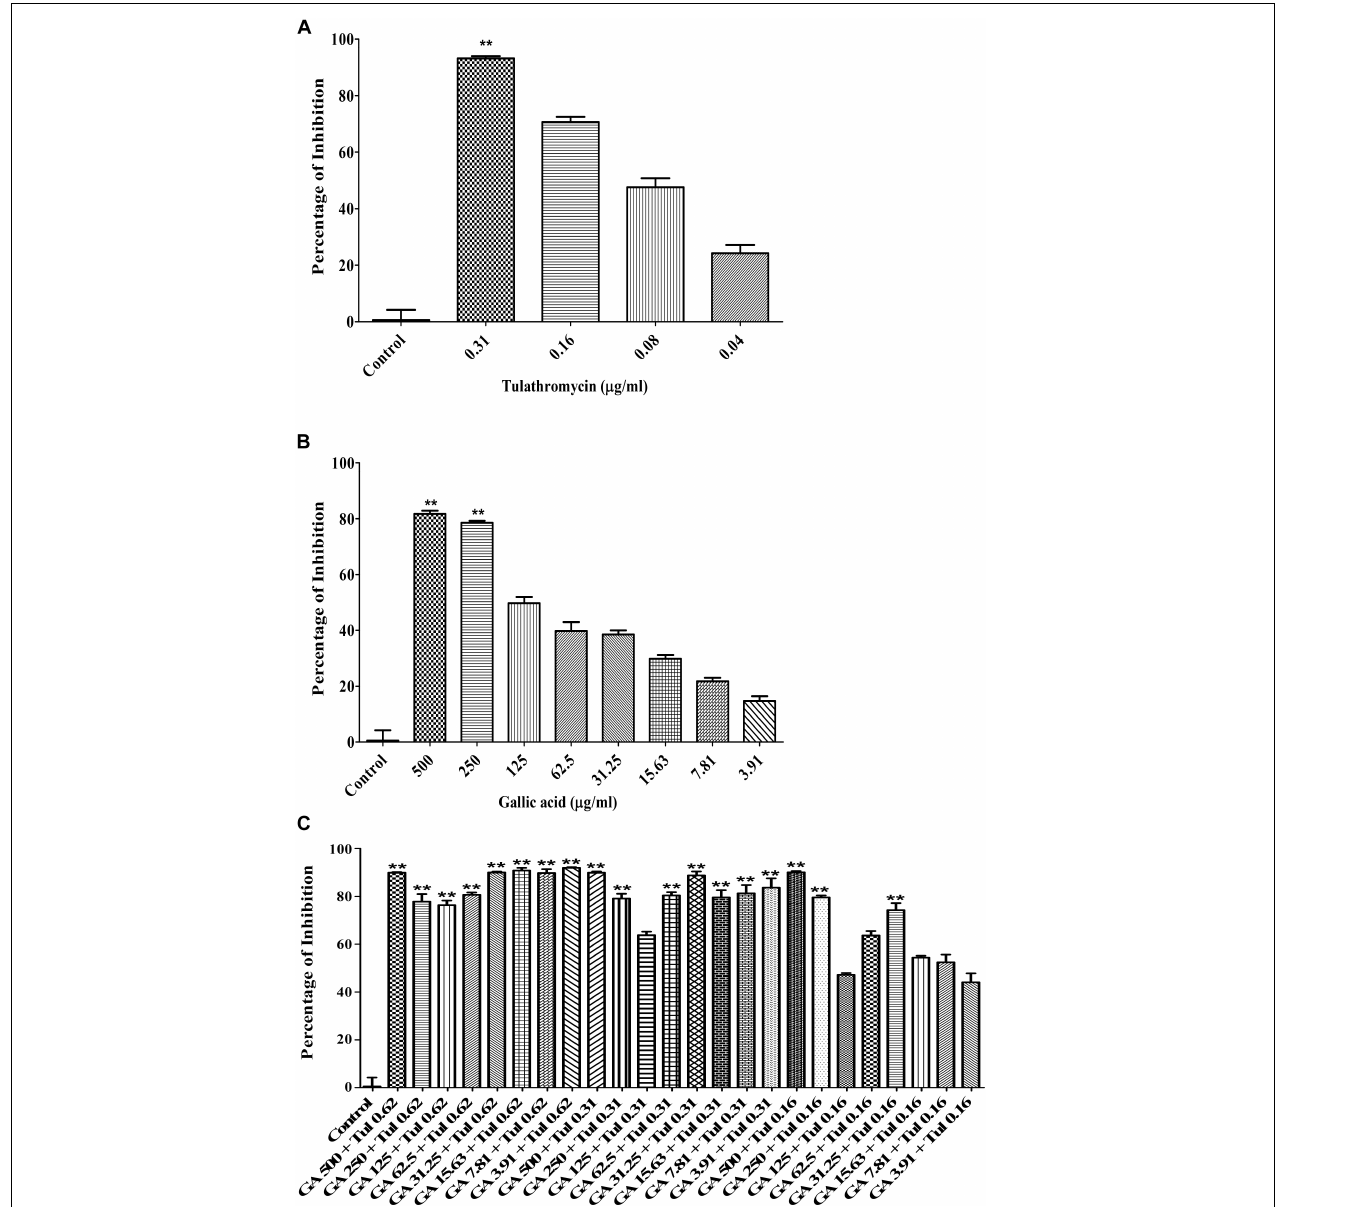
FIGURE 5 | Antimicrobial activity of tylathromycin [ (A) concentration: 0.04 – 0.31 µ g/mL], gallic acid [ (B) concentration: 3.91 – 500 µ g/mL] and combination of tulathromycin and gallic acid [ (C) concentration: tulathromycin 0.16, 0.31, and 0.62 µ g/mL and gallic acid 3.91 – 500 µ g/mL] against the mixed culture of M. haemolytica and P. multocida . One way ANOVA t -test was used for statistical significance. ∗ P -value < 0.05, ∗∗ P -value < 0.01, and ∗∗∗ P -value < 0.001 are shown. Correlation coefficient ( r ) was calculated using Pearson’s correlation method.